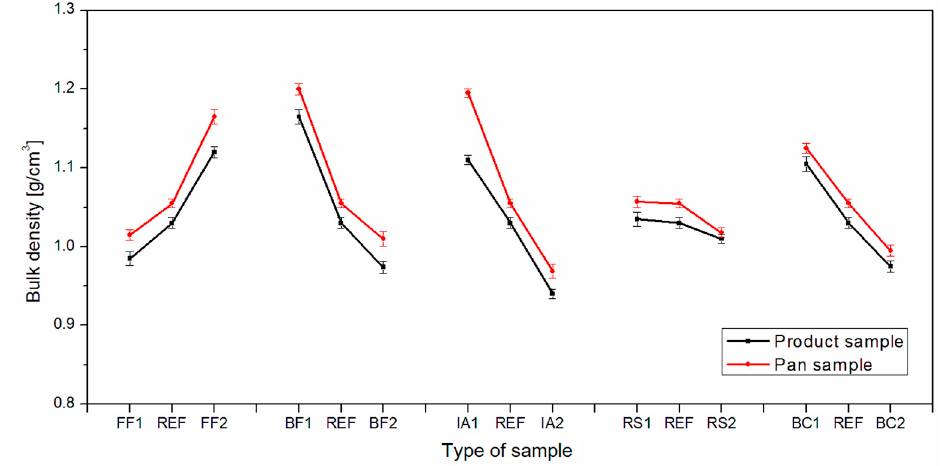
Figure 14. Influence of the operating parameters on bulk density.